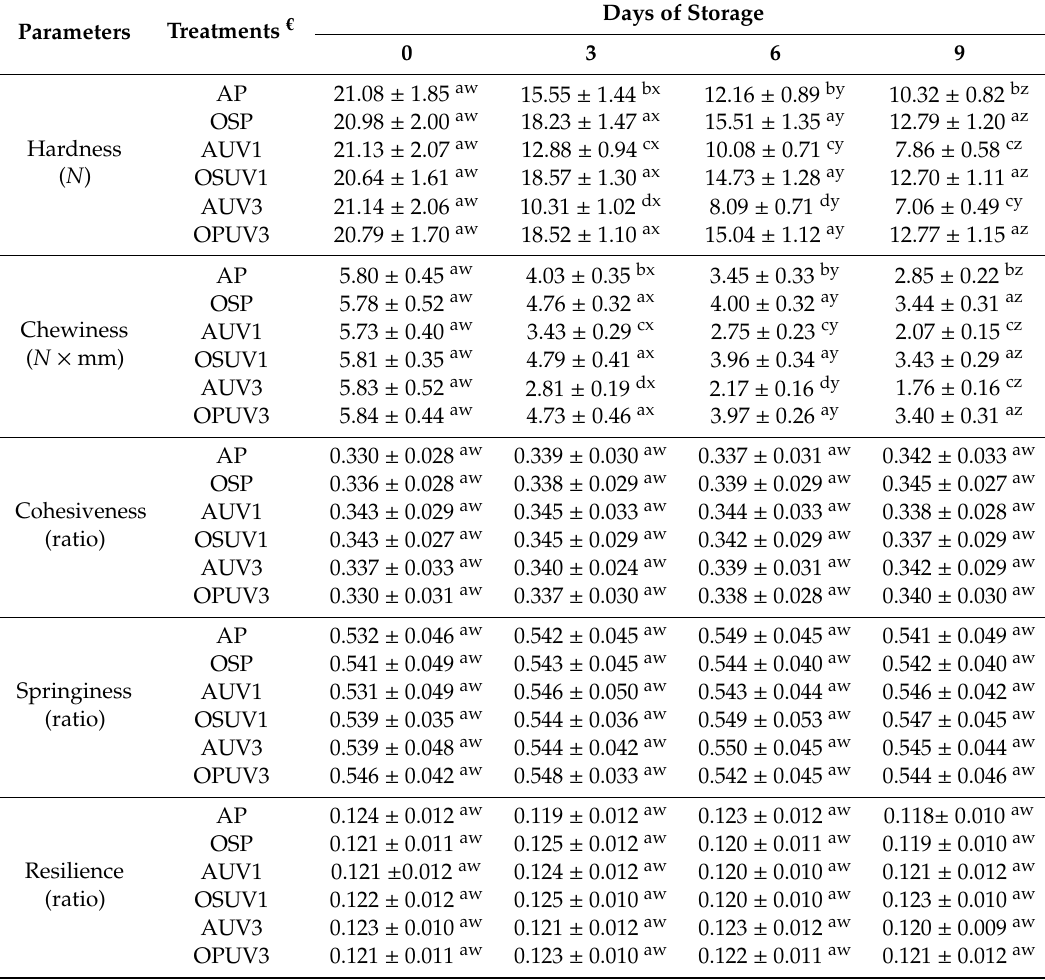
Table 4. Instrumental texture parameters of rainbow trout ( Oncorhynchus mykiss ) fillets non- and treated with oxygen scavenger packaging (OSP) and ultraviolet radiation (UV-C) stored at 4 ± 1 ◦ C for 9